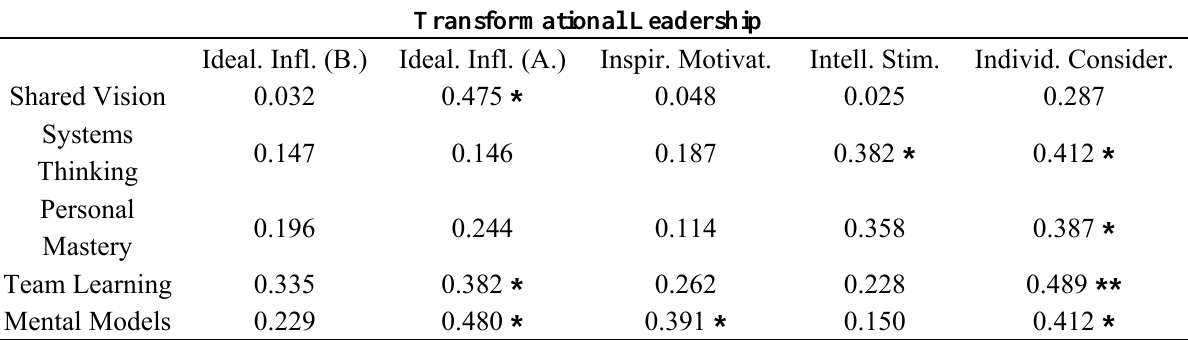
Table 4. Correlations between learning organization characteristics and transformational leadership